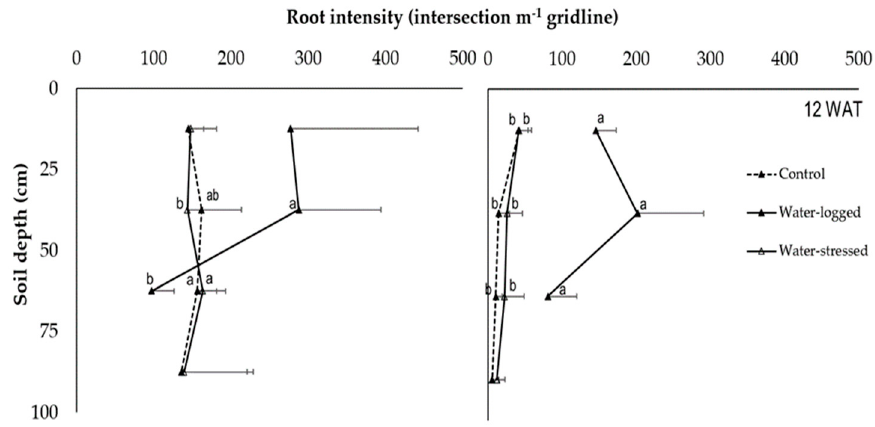
Figure 4. Root intensity (intersection m − 1 gridline) at 12 WAT under water-stress, water-logged, and control treatment at different soil depths for N. cadamba ( left ) and O. sumatrana ( right ). A two-way ANOVA test was used, followed by Tukey’s HSD ( p < 0.05, n = 3). Error bars indicate standard deviation. Different letters indicate that a significant difference was observed between the various conditions for each depth tested.